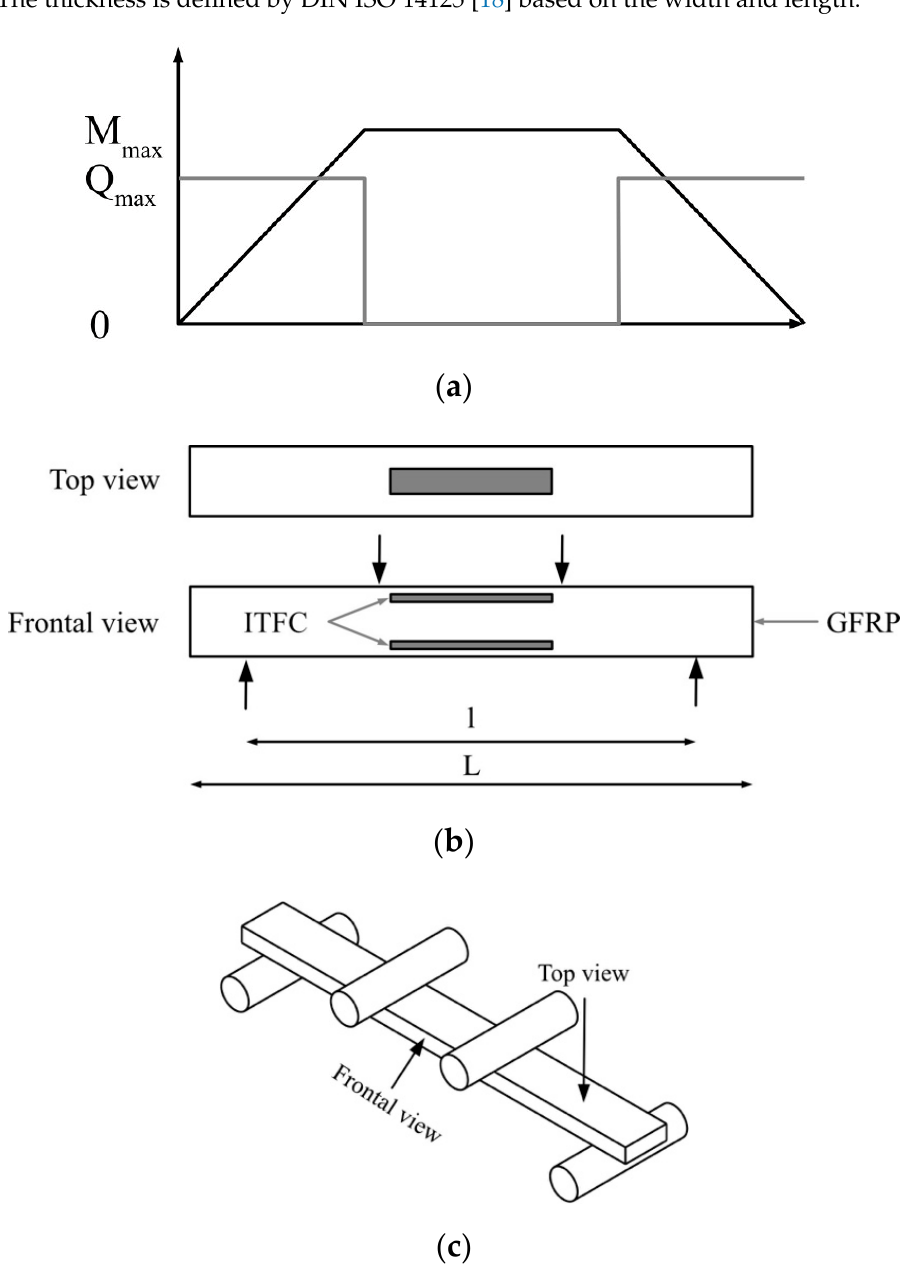
ITFC with the focus on manufacturing by hand. Smaller sizes would not be manageable. The thickness is defined by DIN ISO 14125 [18] based on the width and length.